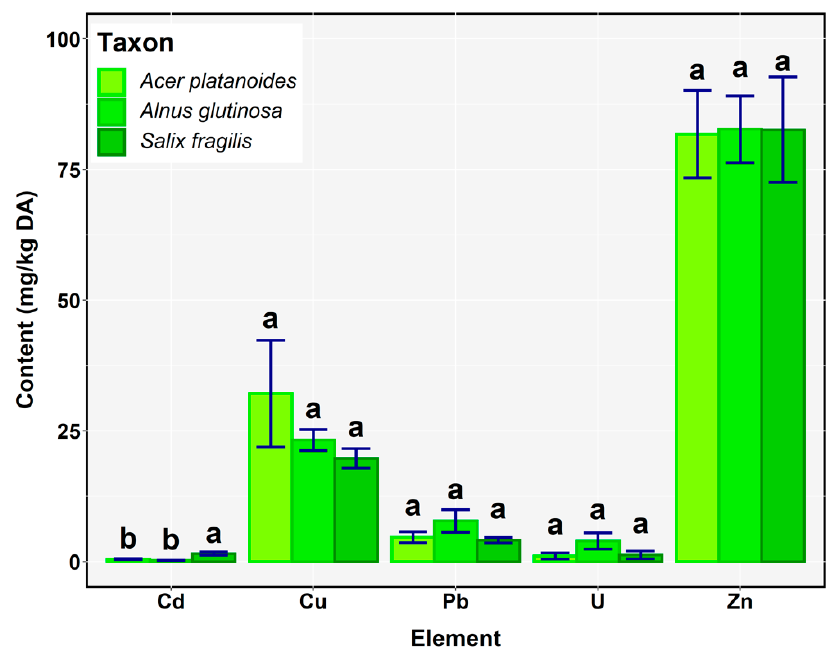
Figure 2. Heavy metal and U content comparison in the leaves of the dominant tree species. Different letters represent statistically significant differences at p < 0.05.